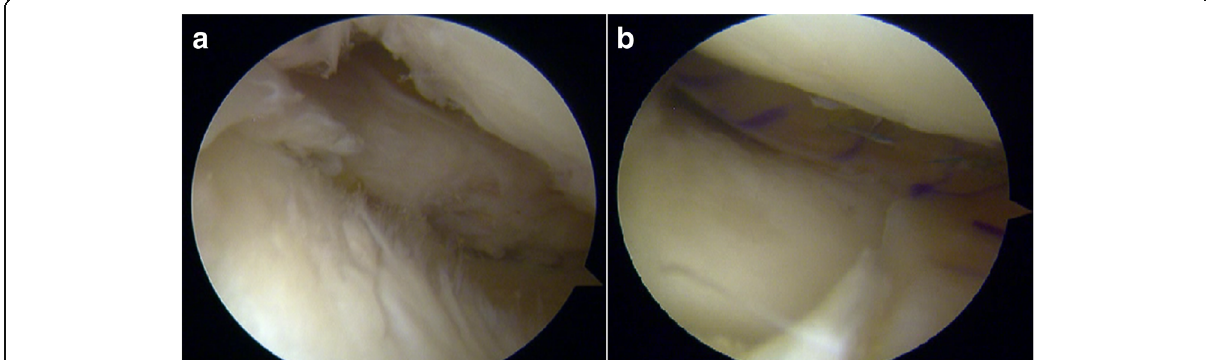
Fig. 7 Arthroscopic evaluation: ( a ) Pre-operative and ( b ) after lateral MAT Patient